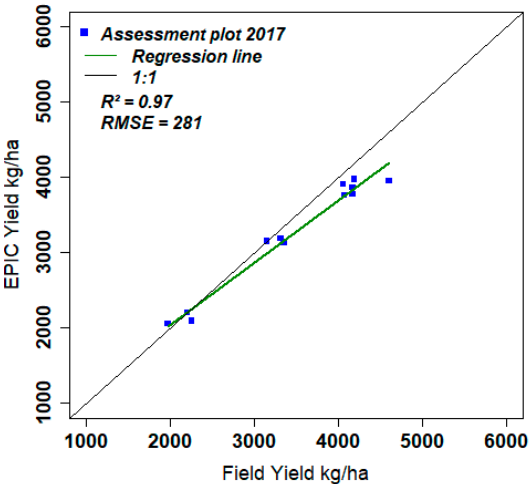
Figure 10. Yield obtained using the modified PARM(3) value that allows to reduce the impact of the water stress on the harvest